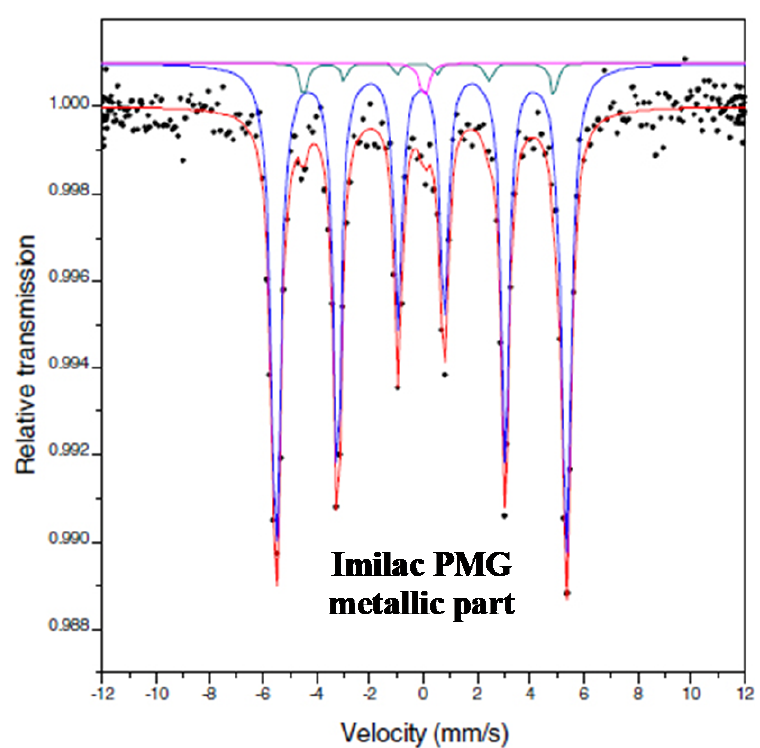
Figure 17. Room temperature Mössbauer spectrum of Imilac PMG metallic alloy. Indicated spectral components are the result of the fit. Adapted from [42].